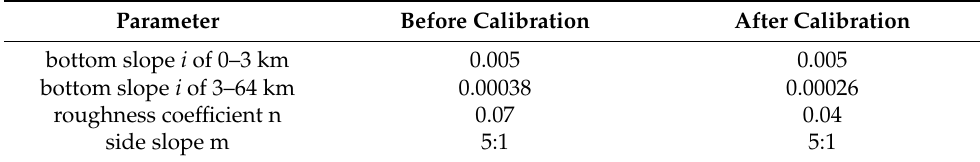
Table 4. Calibration of the main parameters of the model.